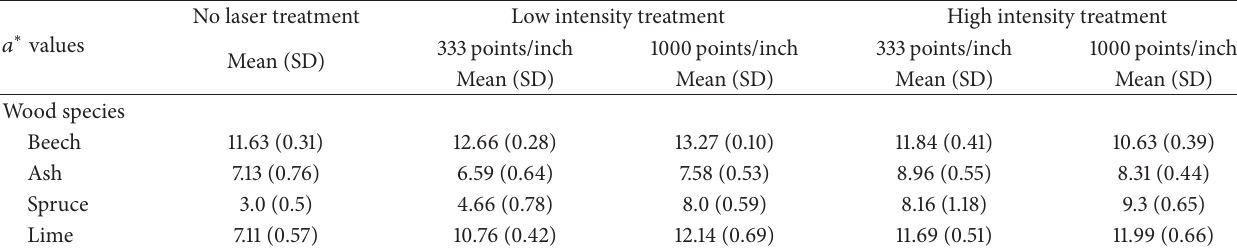
Table 2: Comparison of 𝑎 ∗ values of untreated wood surfaces with laser treated wood surfaces.